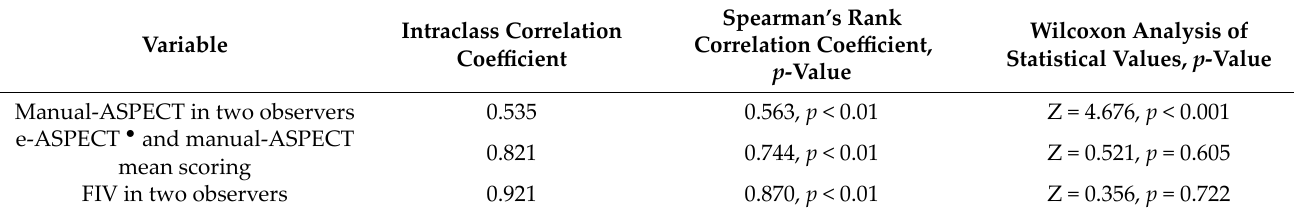
Table 2. The consistent results in e‑ASPECT, manual‑ASPECT, and